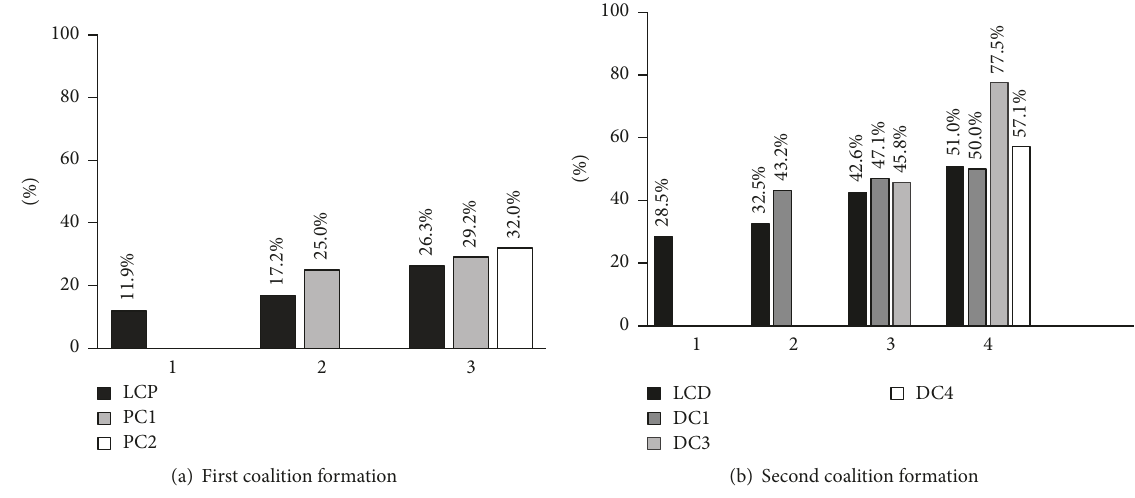
Figure 7: Cost reduction percentage diagram for two